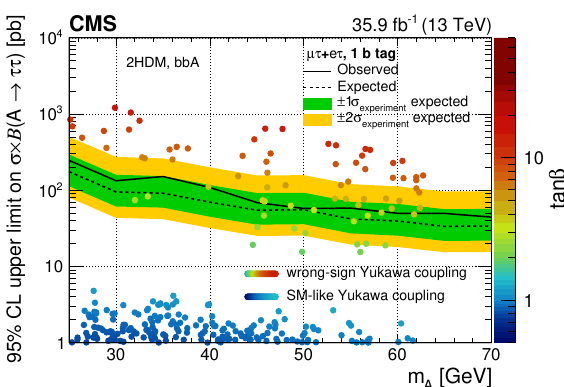
Figure 4 . Observed (solid) and expected (dashed) limits at 95% con(cid:12)dence level on the product of cross section for the production of the bbA signal and branching fraction A ! tt , obtained from the combination of the e t and mt channels. The green and yellow bands represent the one and two h h standard deviation uncertainties in the expected limits. Representative 2HDMs with varied sets of the tan (cid:12) and m parameters are overlaid for two types of Yukawa couplings to the down-type A fermions: one which is SM-like, and one in which the Yukawa coupling is negative (\wrong-sign").